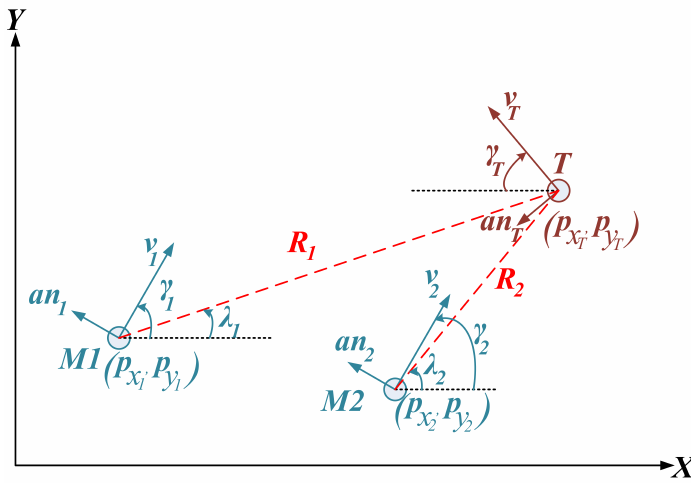
Figure 1. Planar engagement